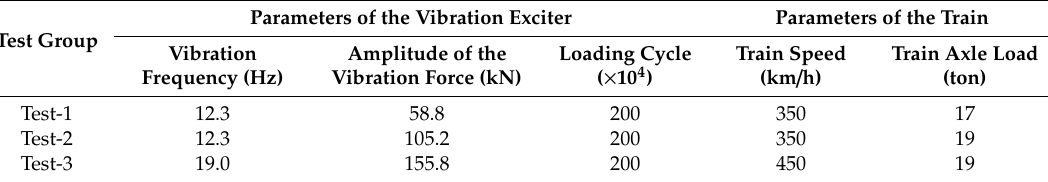
Figure 5. ( a ) In situ vibration exciter and ( b ) the loading form. Table 4. Parameters of the forced vibration